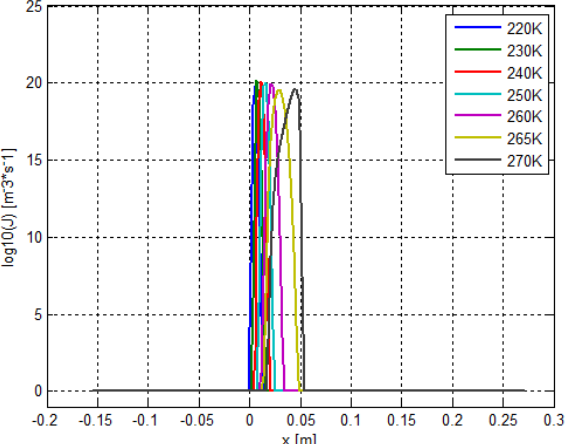
Figure 15. Mach number distribution curves along the axial cross-section of the supersonic separator at inlet pressure values 2, 3.5, 4, 5, and 5.5 MPa.